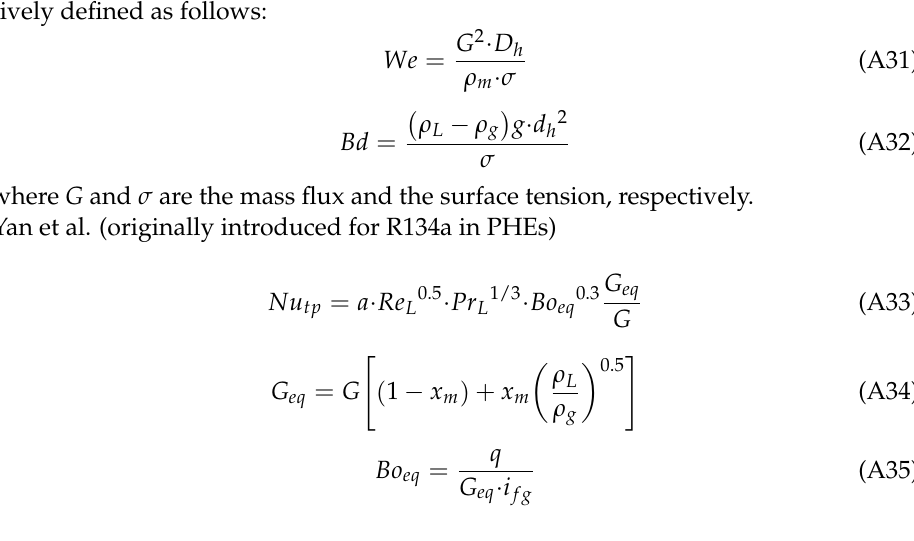
Table A1. The calculated empirical coefficients of the hydraulic model of the PHEs of the ORC system. The Empirical Coefficient in